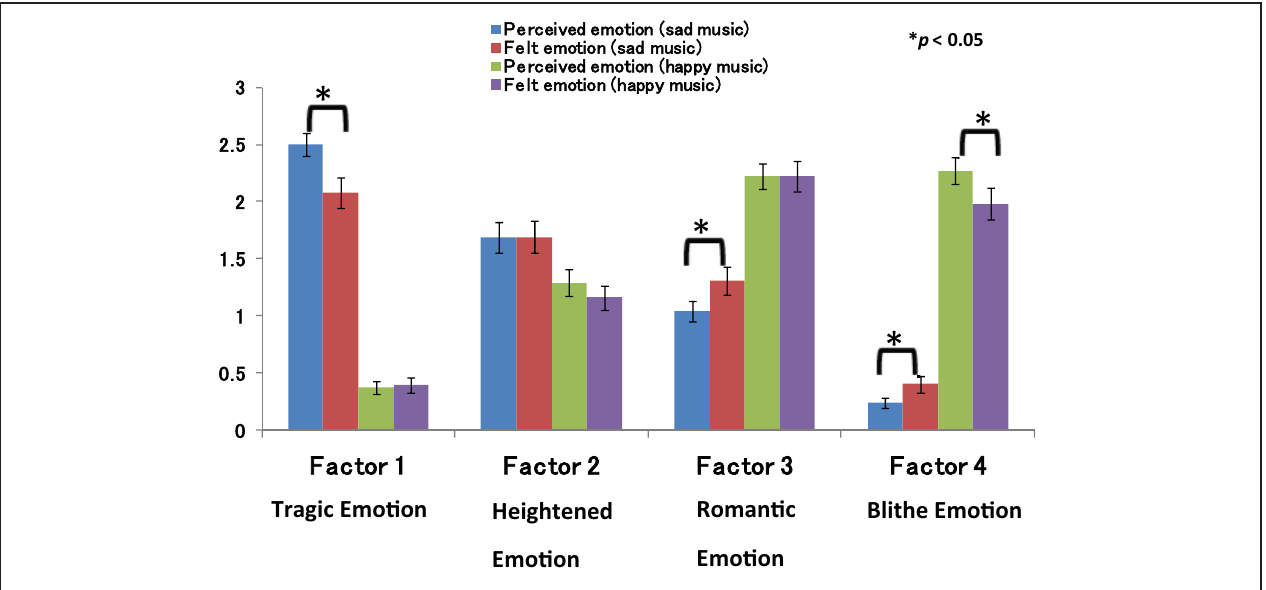
FIGURE 1 | Mean factor scores for perceived and felt emotion ratings for each